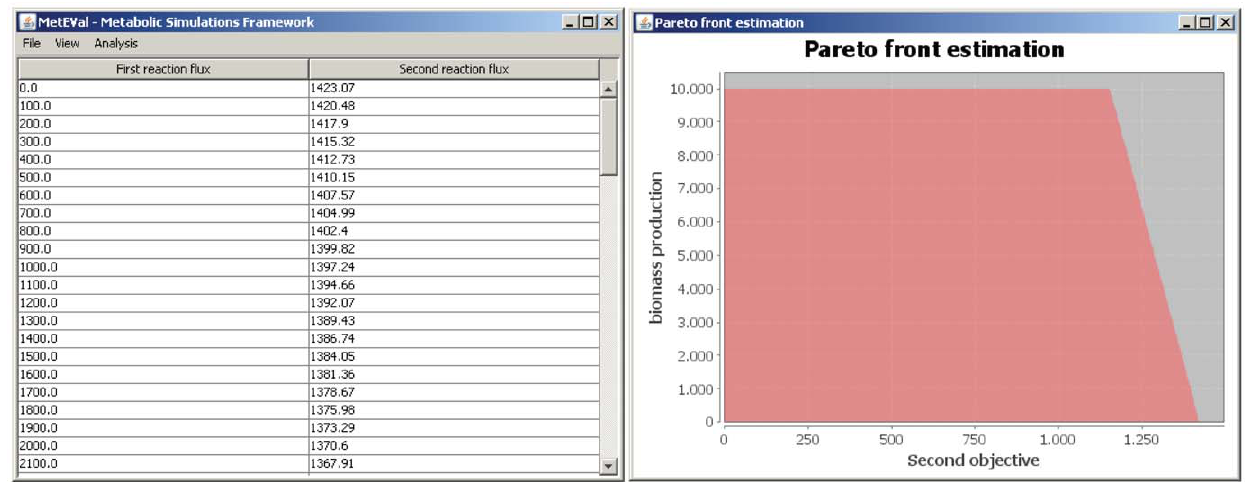
Figure 2. Table and plot output from the Pareto front calculation routine. The first steps are identical to those in Figure 1, except that only one organism is selected and two reactions are selected to calculate their trade-off.